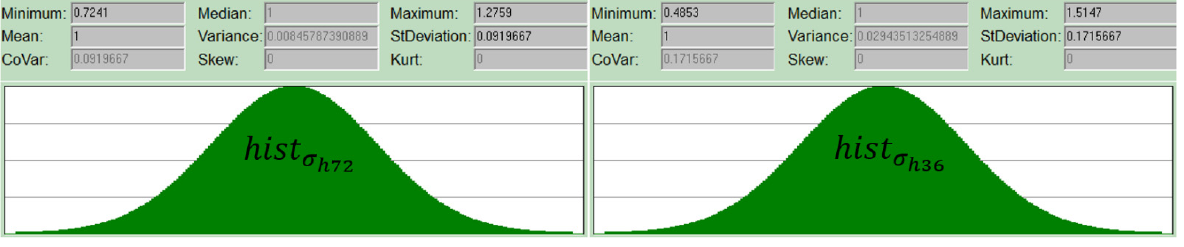
Figure 12. Truncated normal histograms hist σ